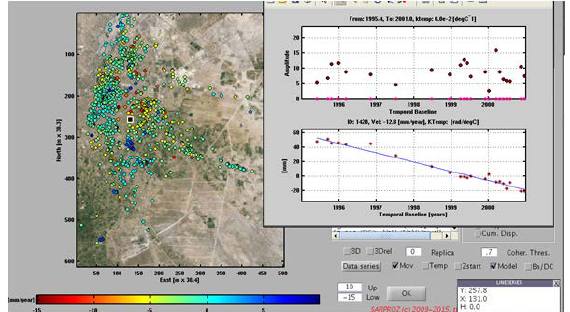
Figure 9. Evaluated movements over urbanized Konya area by ERS PS-InSAR using SarProz